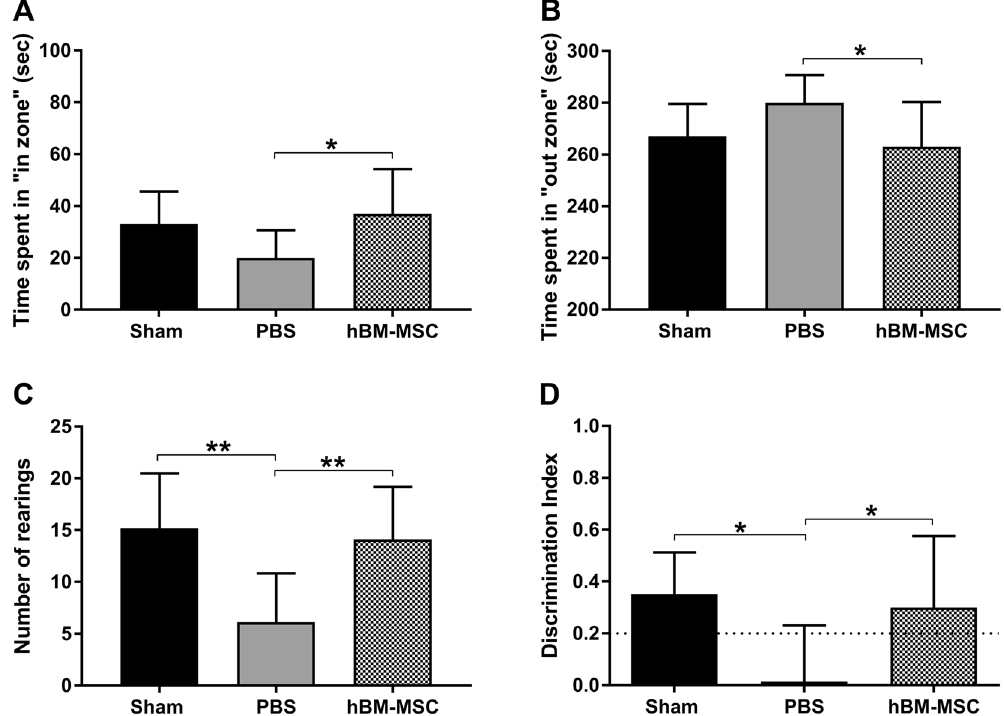
Figure 3. hBM-MSC treatment improves exploratory and cognitive functions in stroke mice. ( A , B ) tMCAo hBM-MSC mice spent more time in “in zone” and less time in “out zone” compared to tMCAo PBS mice. ( C ) The number of rearings was significantly increased in tMCAo hBM-MSC compared to tMCAo PBS mice. ( D ) hBM-MSC treatment induced a decrease of cognitive deficits as shown in NOR. The dotted line indicates the limit below which a memory impairment is present. Data are mean + SD, n = 6–10; ( A ) One-way ANOVA p < 0.05; ( B ) One-way ANOVA p < 0.05; ( C ) One-way ANOVA p < 0.01; ( D ) One-way ANOVA p < 0.05. Tukey’s post-hoc test: * p < 0.05, ** p <